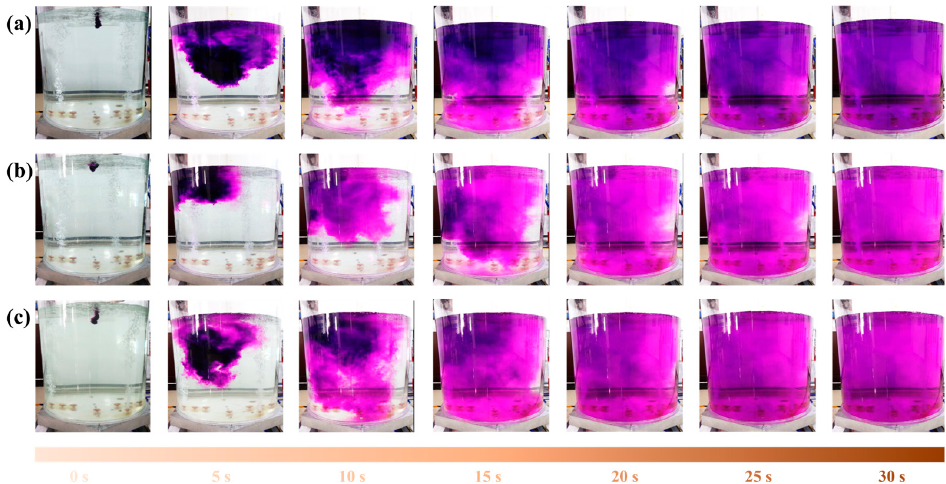
Figure 9. Flow field display diagram of double holes 2, 11 ( a ), 1, 11 ( b ) and 6, 12 ( c ) at 7.6 L/min blowing rate.